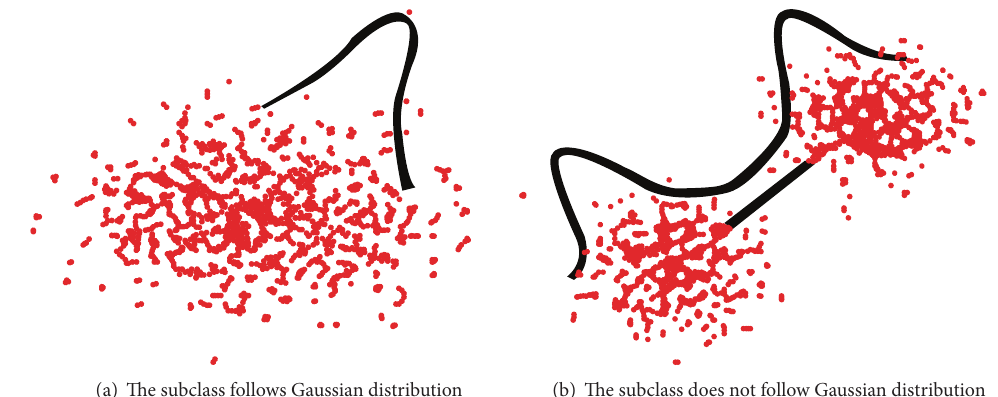
Figure 3: Judge whether each subclass follows Gaussian distribution.